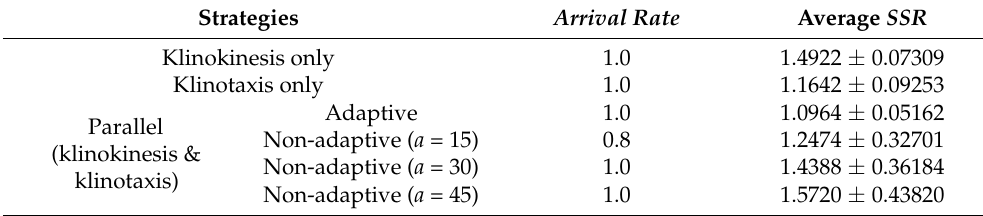
Figure 12. Search performance of all models in scenarios with different concentration gradient ranges. Each point represents the average SSR for the model searches, where the model started from different initial positions and orientations. Table 1. Search performance results for different models across all experiments (±standard devia- tion).